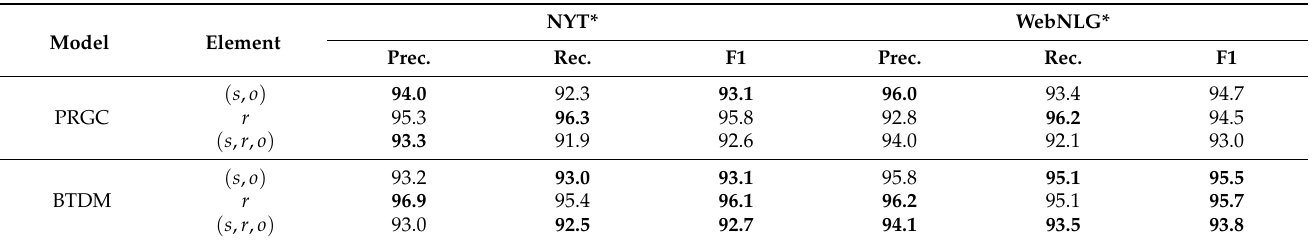
Table 4. Results on different subtasks. ( s , o ) denotes the subtask of the entity pair, r means the subtask of relation, and ( s , r , o ) means the task of relational